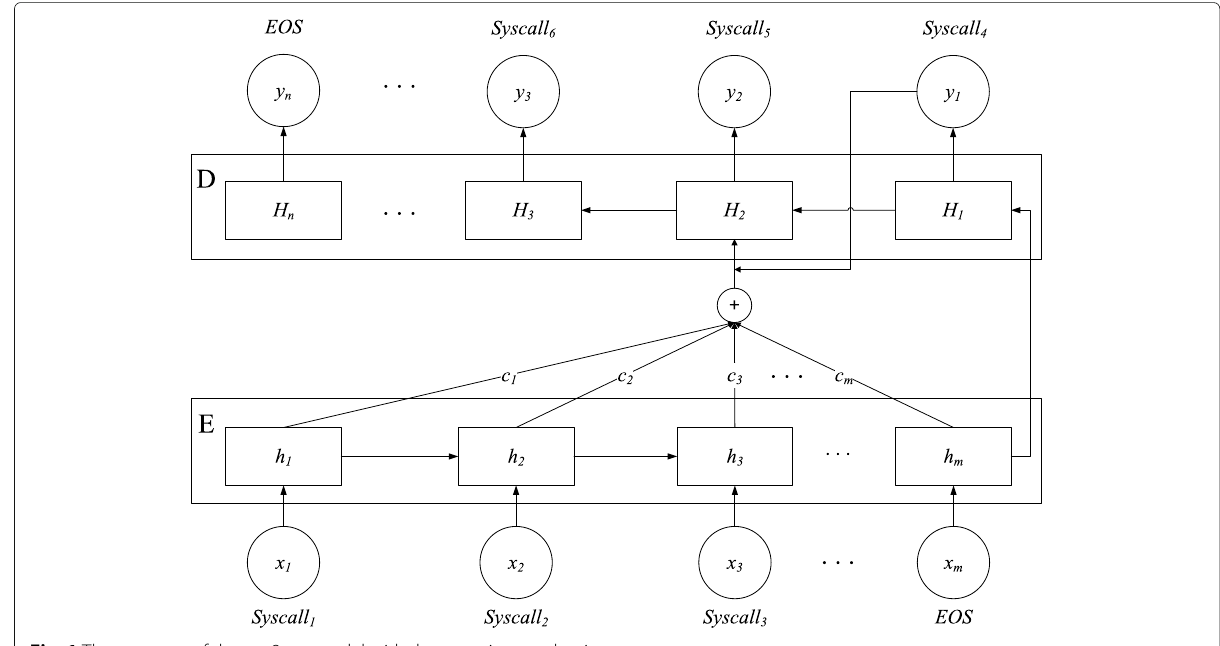
Fig. 1 The structure of the seq2seq model with the attention mechanism